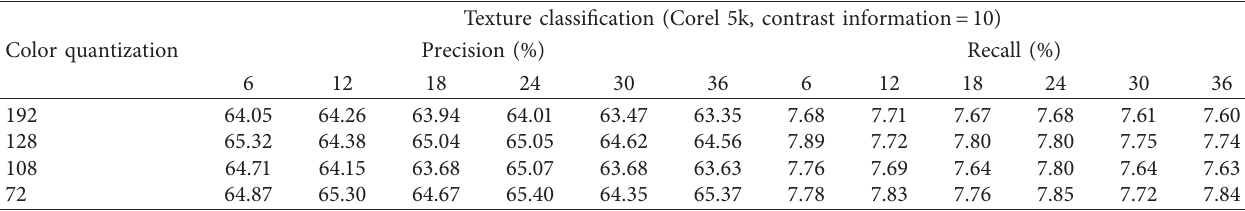
Table 2: Average retrieval precision and average retrieval recall of NRLGO at varying values of gradient orientation and color quantization levels by keeping local contrast information fixed at 10 on Corel 5k in HSV.